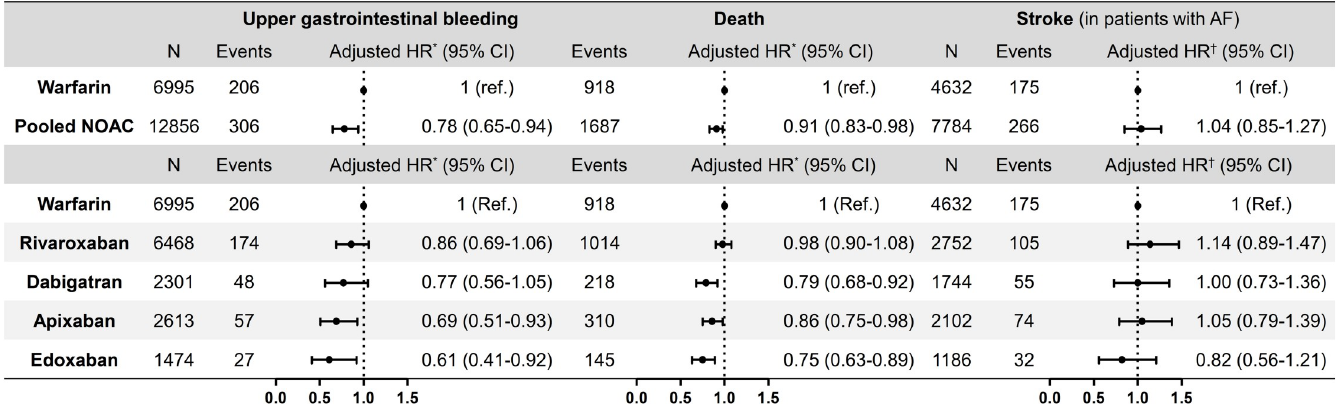
(p = 0.216, p = 0.334, and p = 0.268, respectively), though there was a trend for decreasing adjusted HRs in the order of rivaroxaban, dabigatran, apixaban, and edoxaban ( S6, S8, and S10 Tables in S1 File ). Among NOAC users, 65.8% (n = 8,460) were prescribed reduced dose of NOACs. Reduced doses of NOACs were defined as 15 or 10 mg rivaroxaban once daily, 110 mg dabigatran twice daily, 2.5 mg apixaban twice daily, and 30 mg edoxaban once daily, while regular doses of